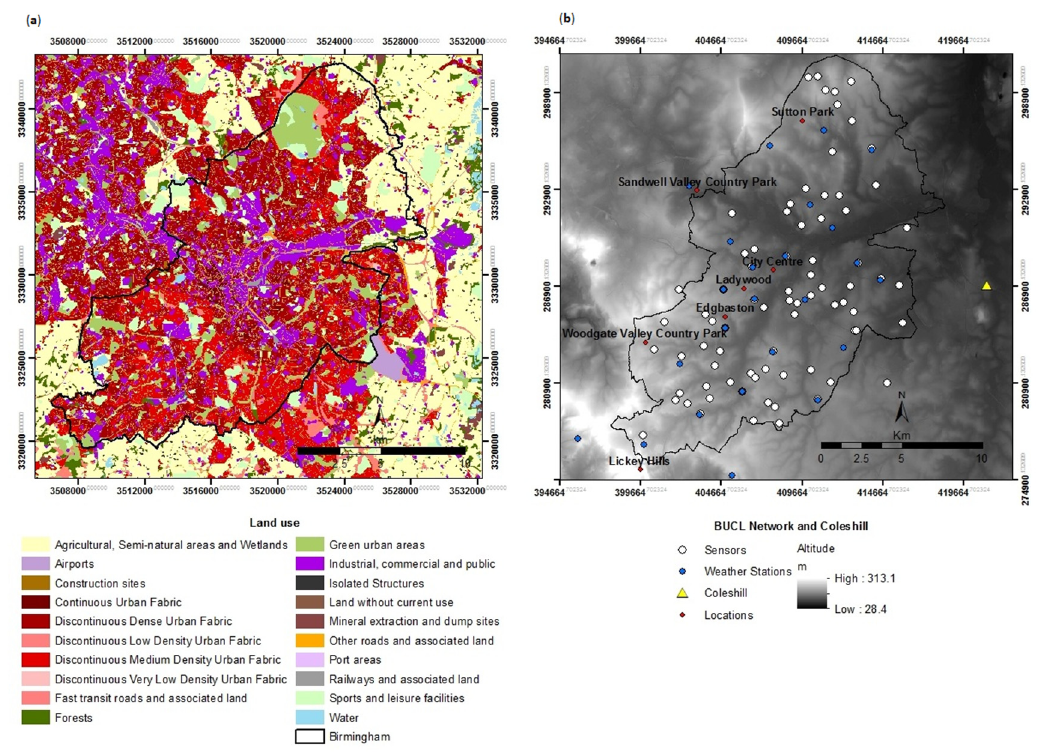
Figure 1. Birmingham—UK ( a ) Land use classes in Birmingham [37]; ( b ) Variation of altitude and location of laces mentioned in the text.